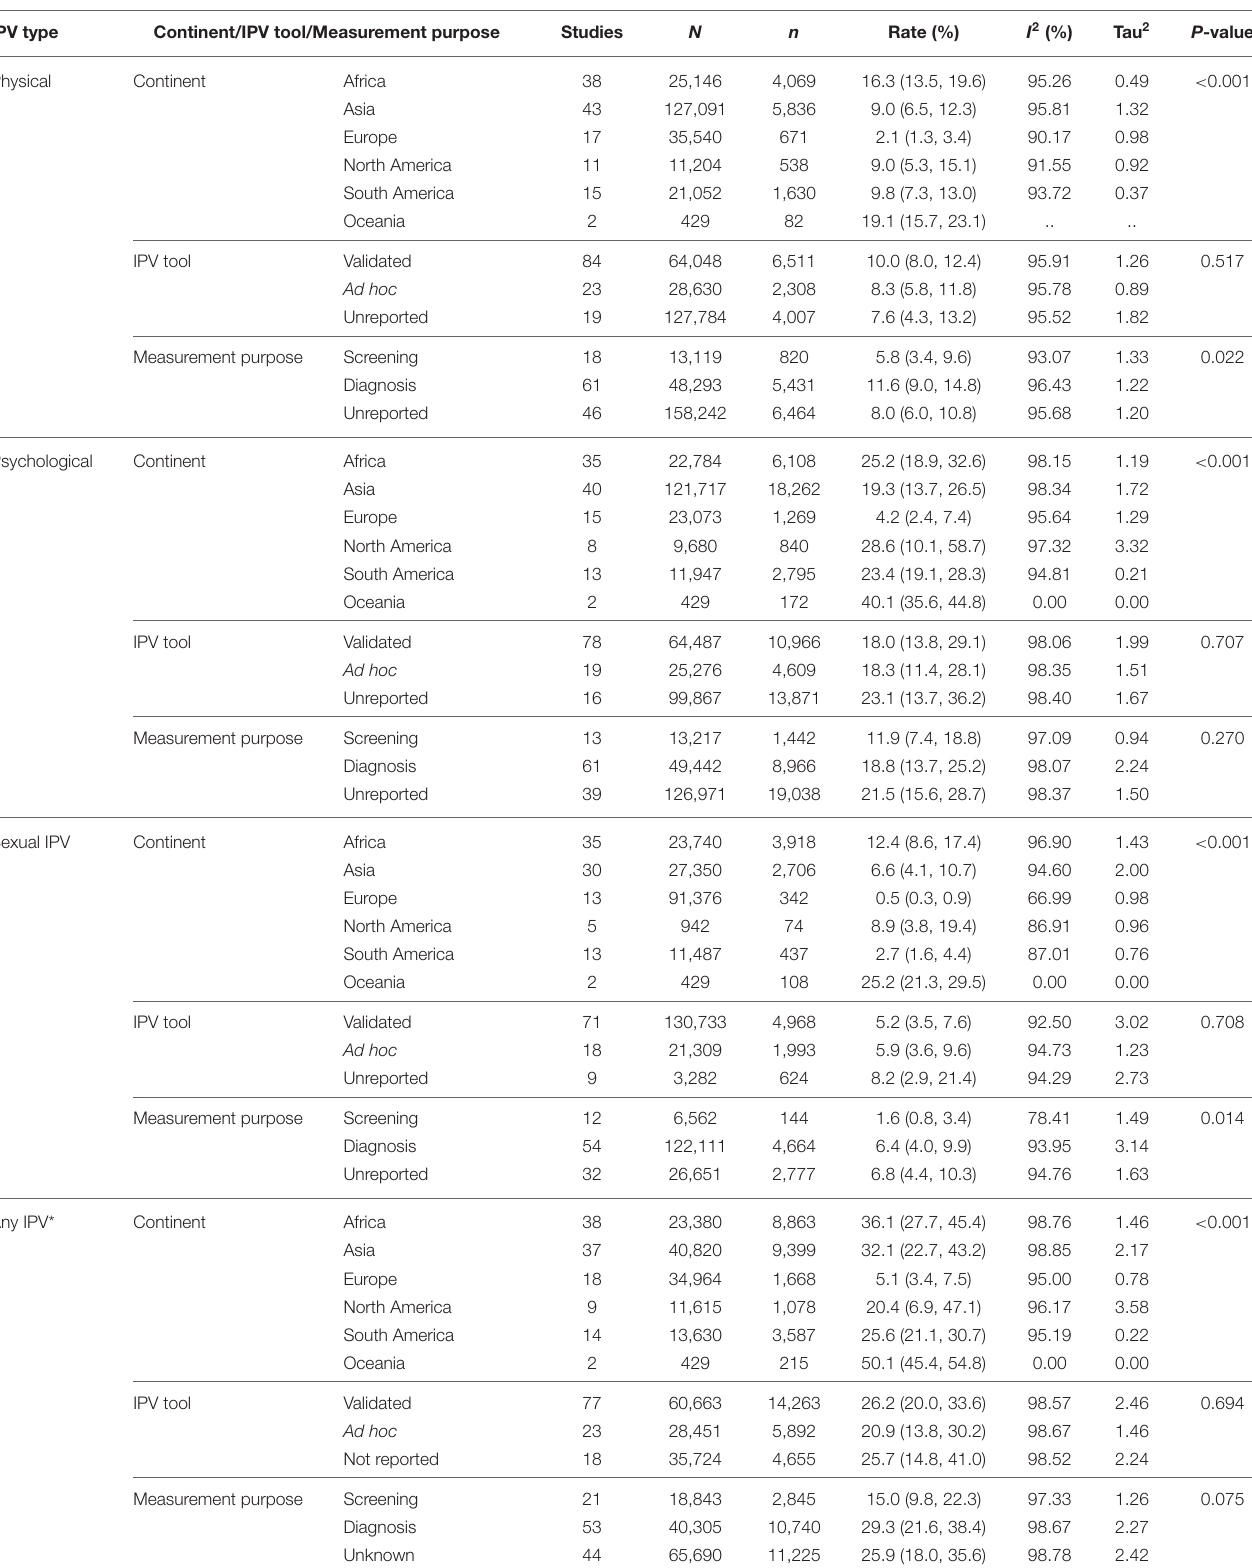
TABLE 2 | Worldwide prevalence data for intimate partner violence (IPV) in pregnancy according to type of violence. IPV